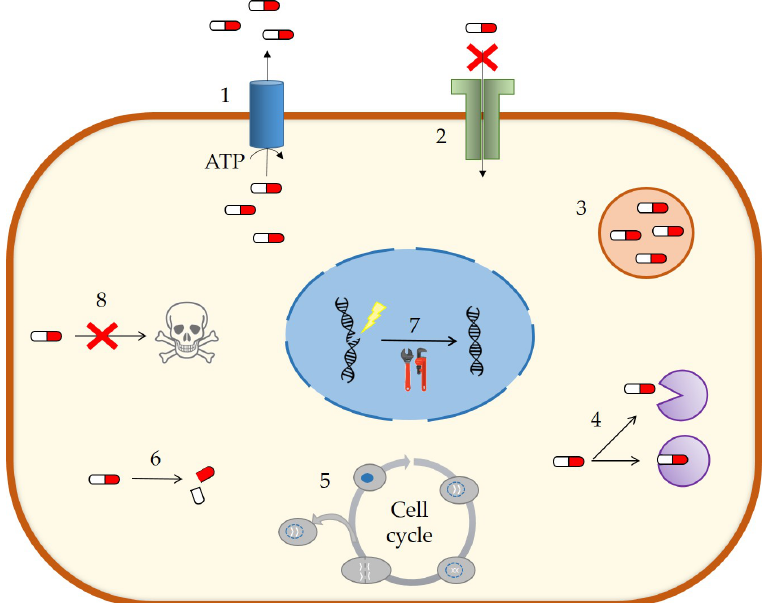
Figure 4. MDR mechanisms in cancer cells. Multidrug resistance can be associated to different biochemical processes: (1) active efflux of compounds, (2) loss of surface receptors or alterations in the cell membrane, (3) drug compartmentalization, (4) alteration of drug targets, (5) changes in the cell cycle, (6) elevated drug metabolism, (7) activation of DNA damage repair systems, and (8) inhibition of apoptosis. Adapted from